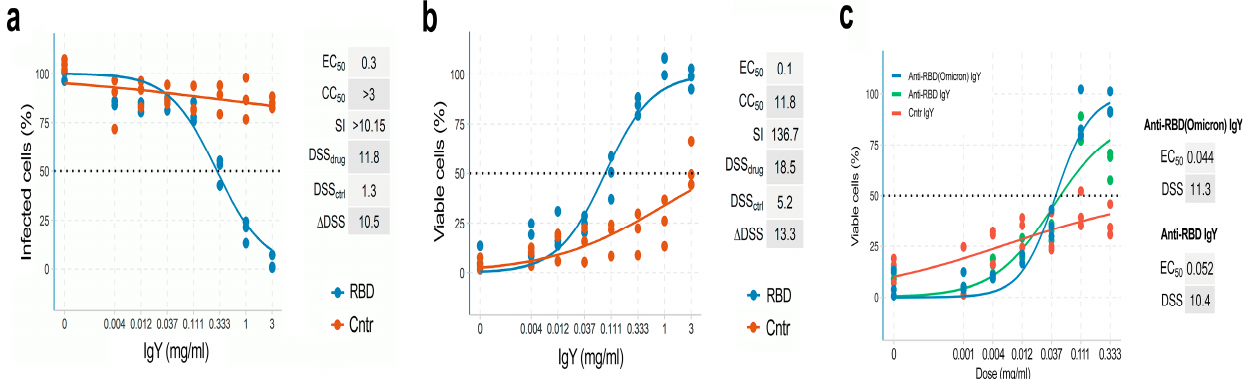
Figure 2. Anti-RBD IgY antibodies produced in chicken eggs neutralize SARS-CoV-2/Wuhan and SARS-CoV-2/Omicron in vitro. ( a ) Neutralization capacity of anti-RBD Wuhan and control non-immune IgYs was measured by monitoring mCherry fluorescence of Vero-E6 cells after 48 h of infection with mCherry-encoded SARS-CoV-2/Wuhan. Mean; n = 3. ( b ) Neutralization capacity of anti-RBD Wuhan and control non-immune IgYs was measured by monitoring viability of Vero-E6 cells after 48 h of infection with mCherry-encoded SARS-CoV-2/Wuhan. Mean; n = 3. ( c ) Neutralization capacity of anti-RBD Wuhan, anti-RBD Omicron, and control non-immune IgY was measured by monitoring viability of Vero-E6 cells after 48 h of infection with SARS-CoV-2/Omicron. Mean; n = 3.